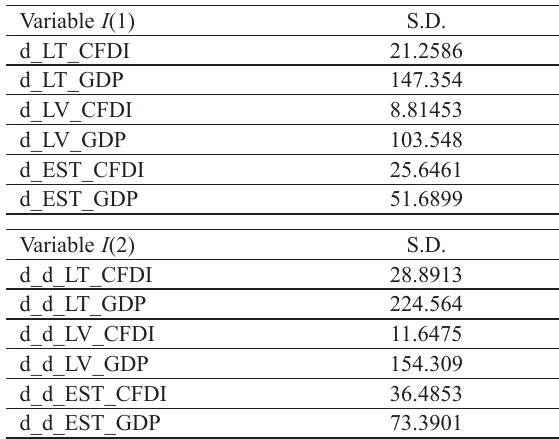
Fig. 6. Time series plots of Estonia’s CFDI and the construction’s contribution to GDP Table 2. Variance of the time